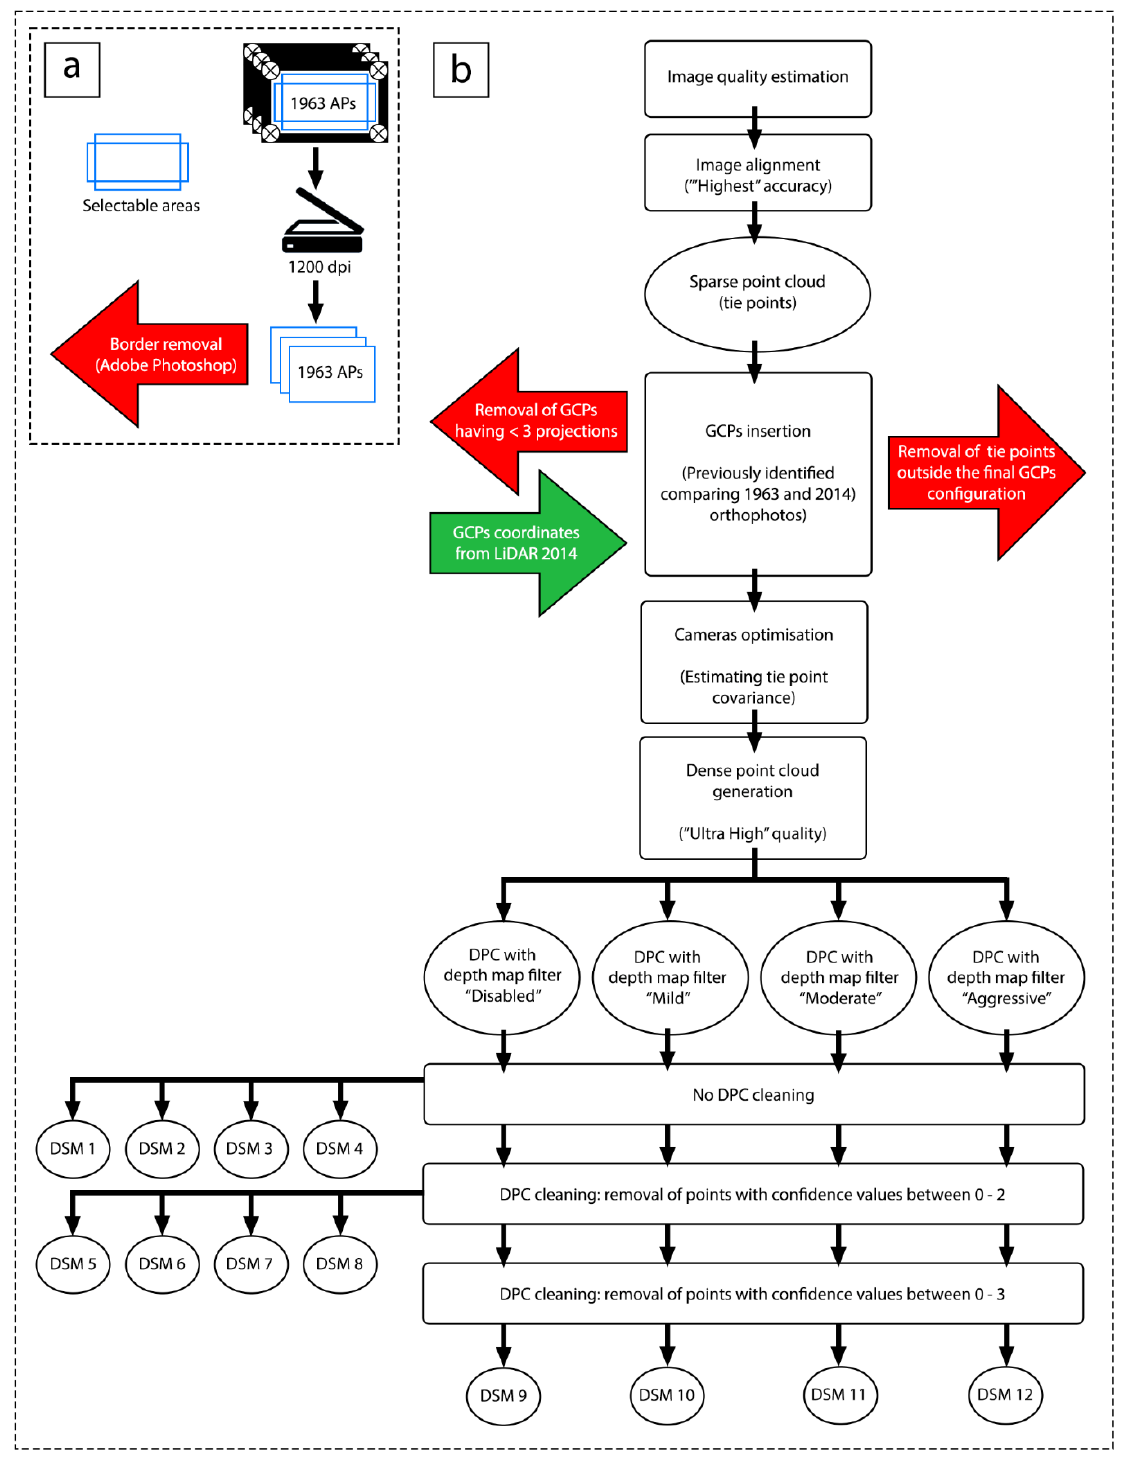
Figure 2. Preparation workflow of aerial photographs (APs) from 1963 prior to the structure-from-motion process ( a ) and main steps ( b ) of the SfM process adopted for the APs from 1963 to produce the 12 digital surface models.